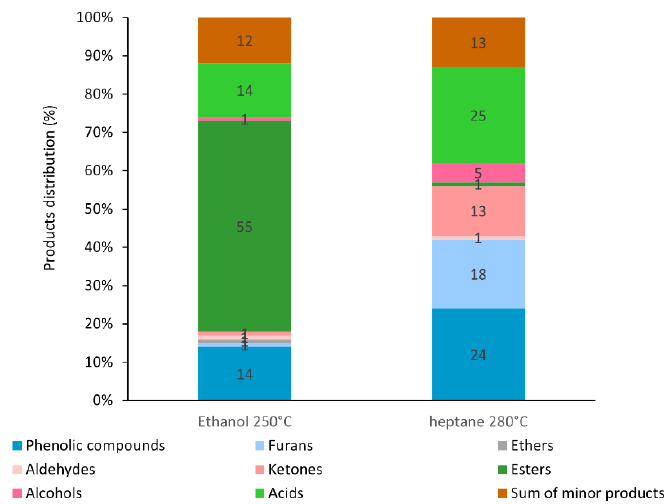
Figure 4. Light products distribution in near SC ethanol and near SC n-heptane. Conditions: Batch reactor. m pine wood = 2.5 g, m solvent = 27 g, 1 h in near critical ethanol or near critical n-heptane at 250 °C or 280 °C.